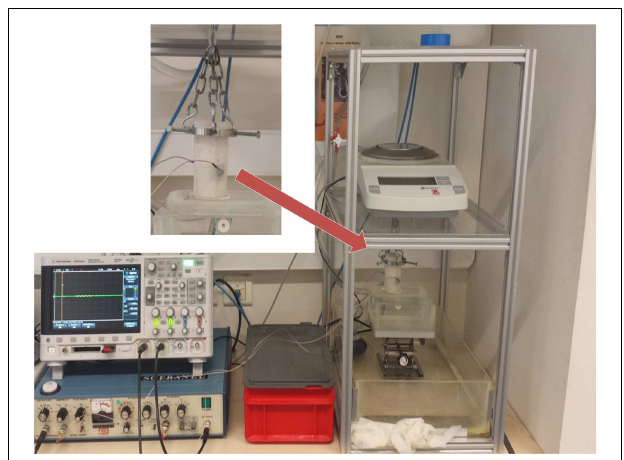
FIGURE 4 | Experimental device for imbibition experiments coupling ultrasonic measurements with mass intake method. The sample is hanging under an electronic balance, above a water tank and ultrasonic sensors are connected to a high voltage pulse-receiver and an